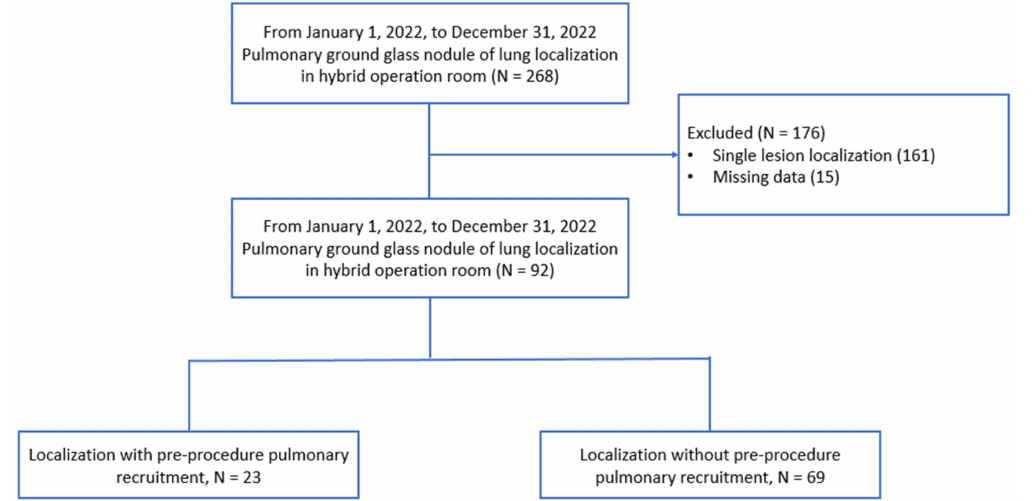
Figure 1. Flowchart of patient classification after their initial inclusion in the